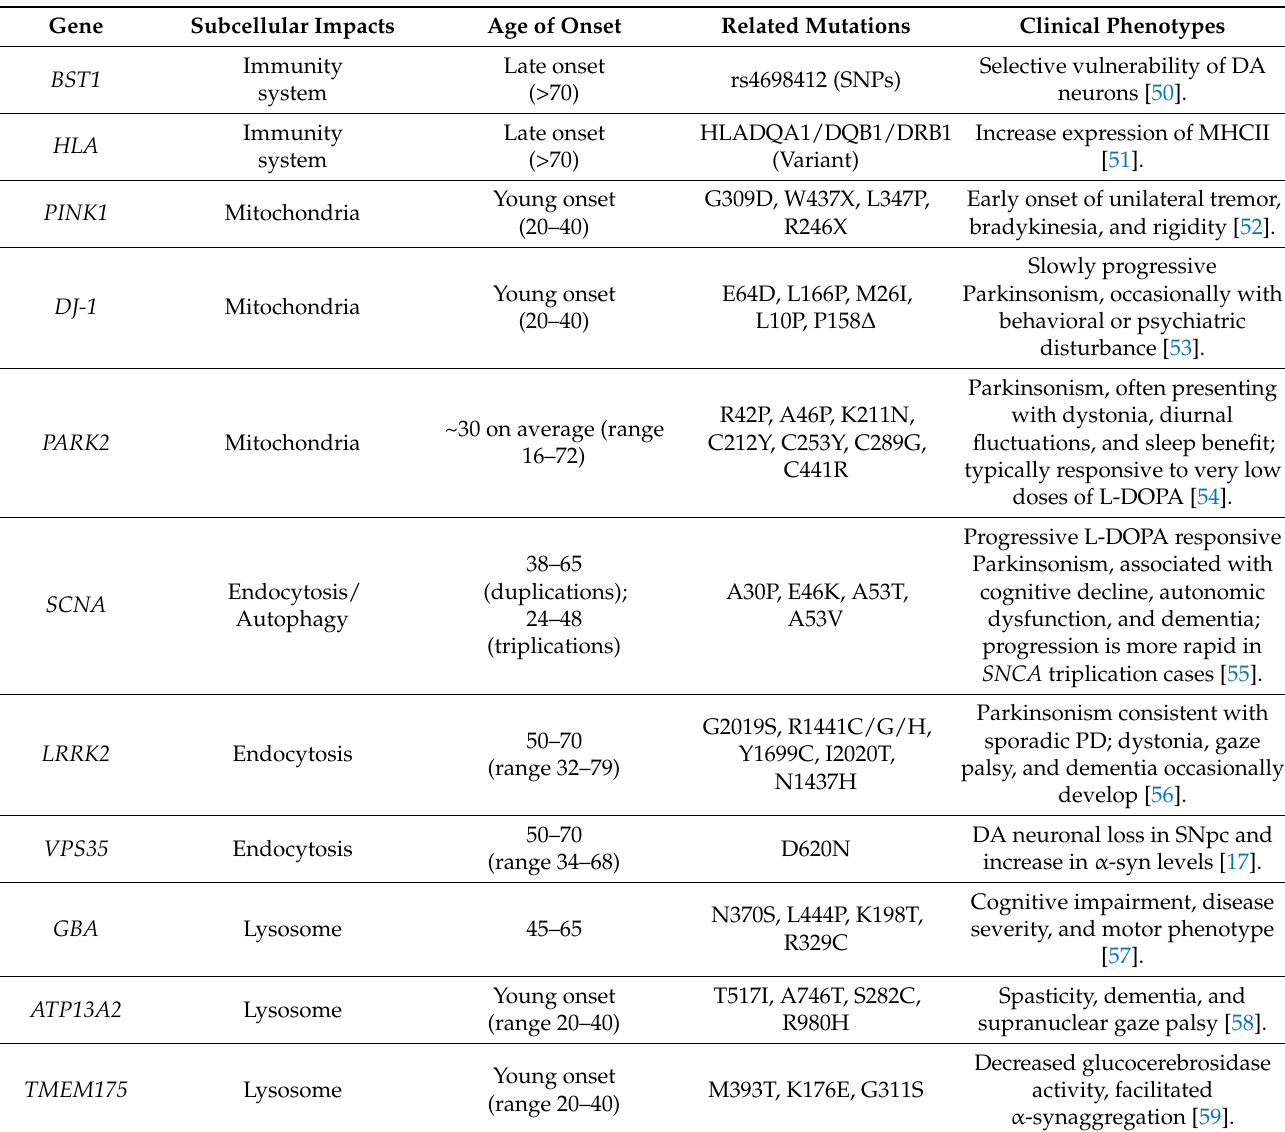
Table 1. Genetic causes of